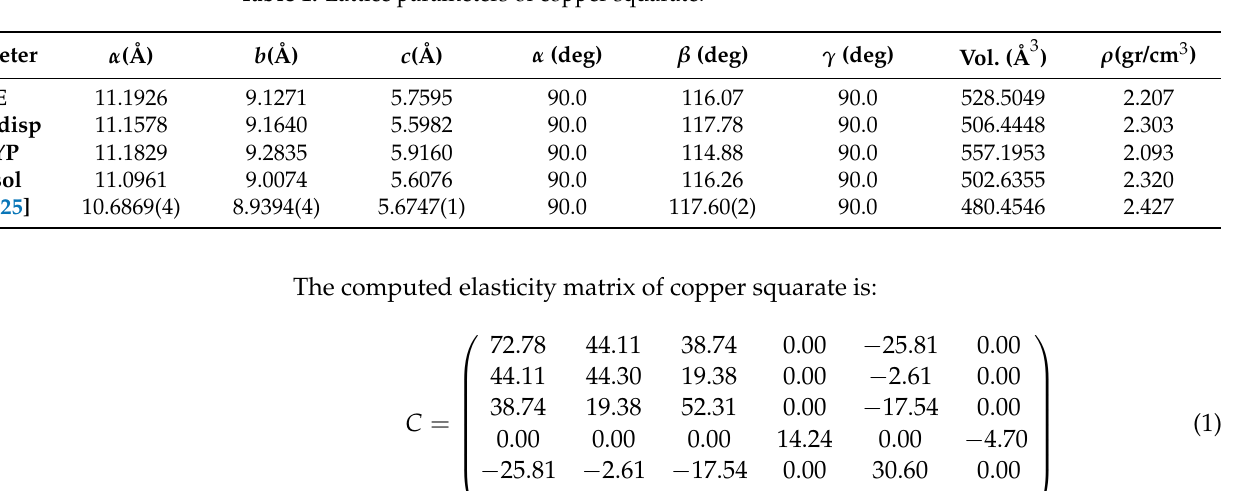
Figure 2. A channel in the crystal structure of copper squarate displayed by means of the corresponding solvent-accessible surface in a 1 × 1 × 5 supercell. Table 1. Lattice parameters of copper